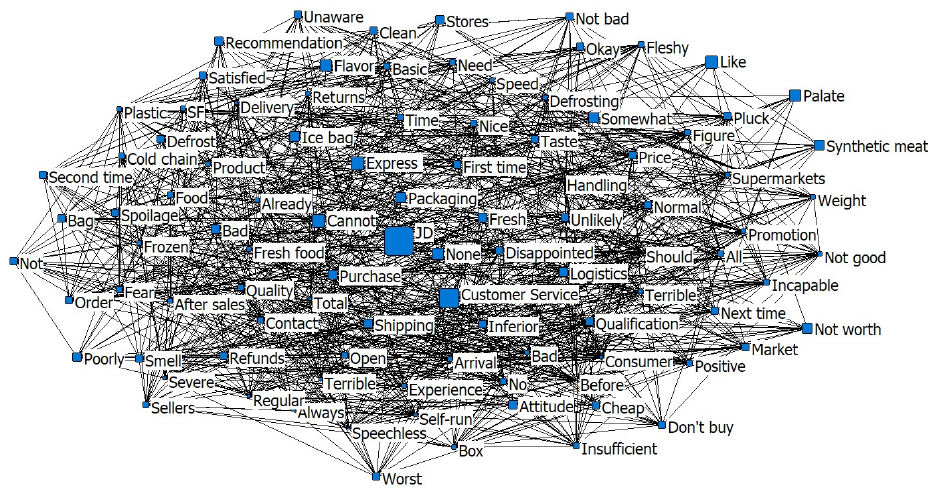
Figure 10. Analysis of closeness